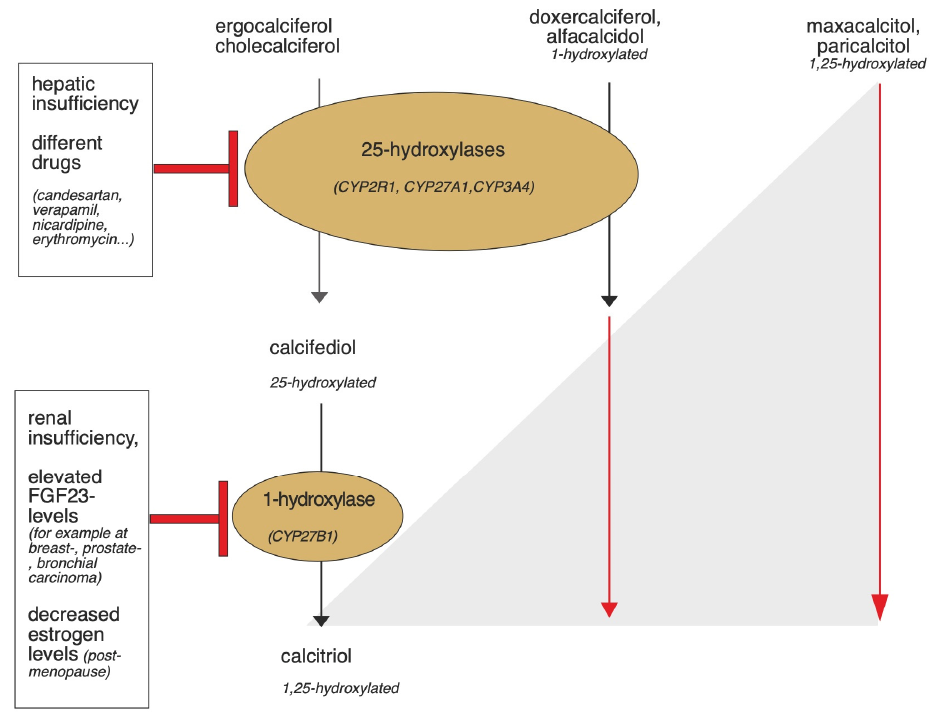
Figure 3. Graphical summary of the activation of vitamin D and vitamin D analogues by the 1- and 25-hydroxylases and potential triggers that may lead to enzyme dysfunction. In hepatic insufficiency or due to the influence of certain drugs, the function of 25-hydroxylases can be impaired [28–30]. Renal insufficiency, elevated FGF23 levels, and decreased estrogen levels may affect the functionality of 1-hydroxylase [31–34]. While cholecalciferol and ergocalciferol are activated by the 1- and 25-hydroxylases, the activation of some synthetic vitamin D analogues occurs independently of renal and extrarenal 1-hydroxylase, because they are already hydroxylated at the first carbon atom. Calcitriol, doxercalciferol, and alfacalcidol need only be activated by 25-hydroxylase. Maxacalcitol and paricalcitol bypass both 1 and 25-hydroxylation since they are already hydroxylated at the 1st and 25th carbon atom [35].